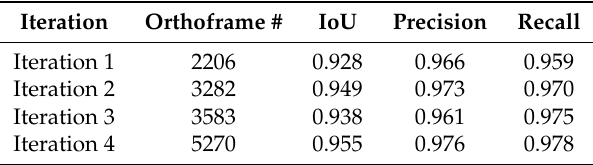
Table 5. Road area segmentation metrics for the test set over iterations.